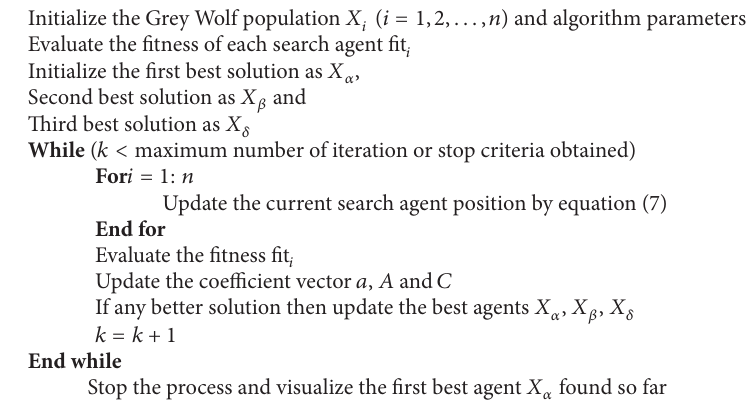
Algorithm 1: Pseudocode for the GWO